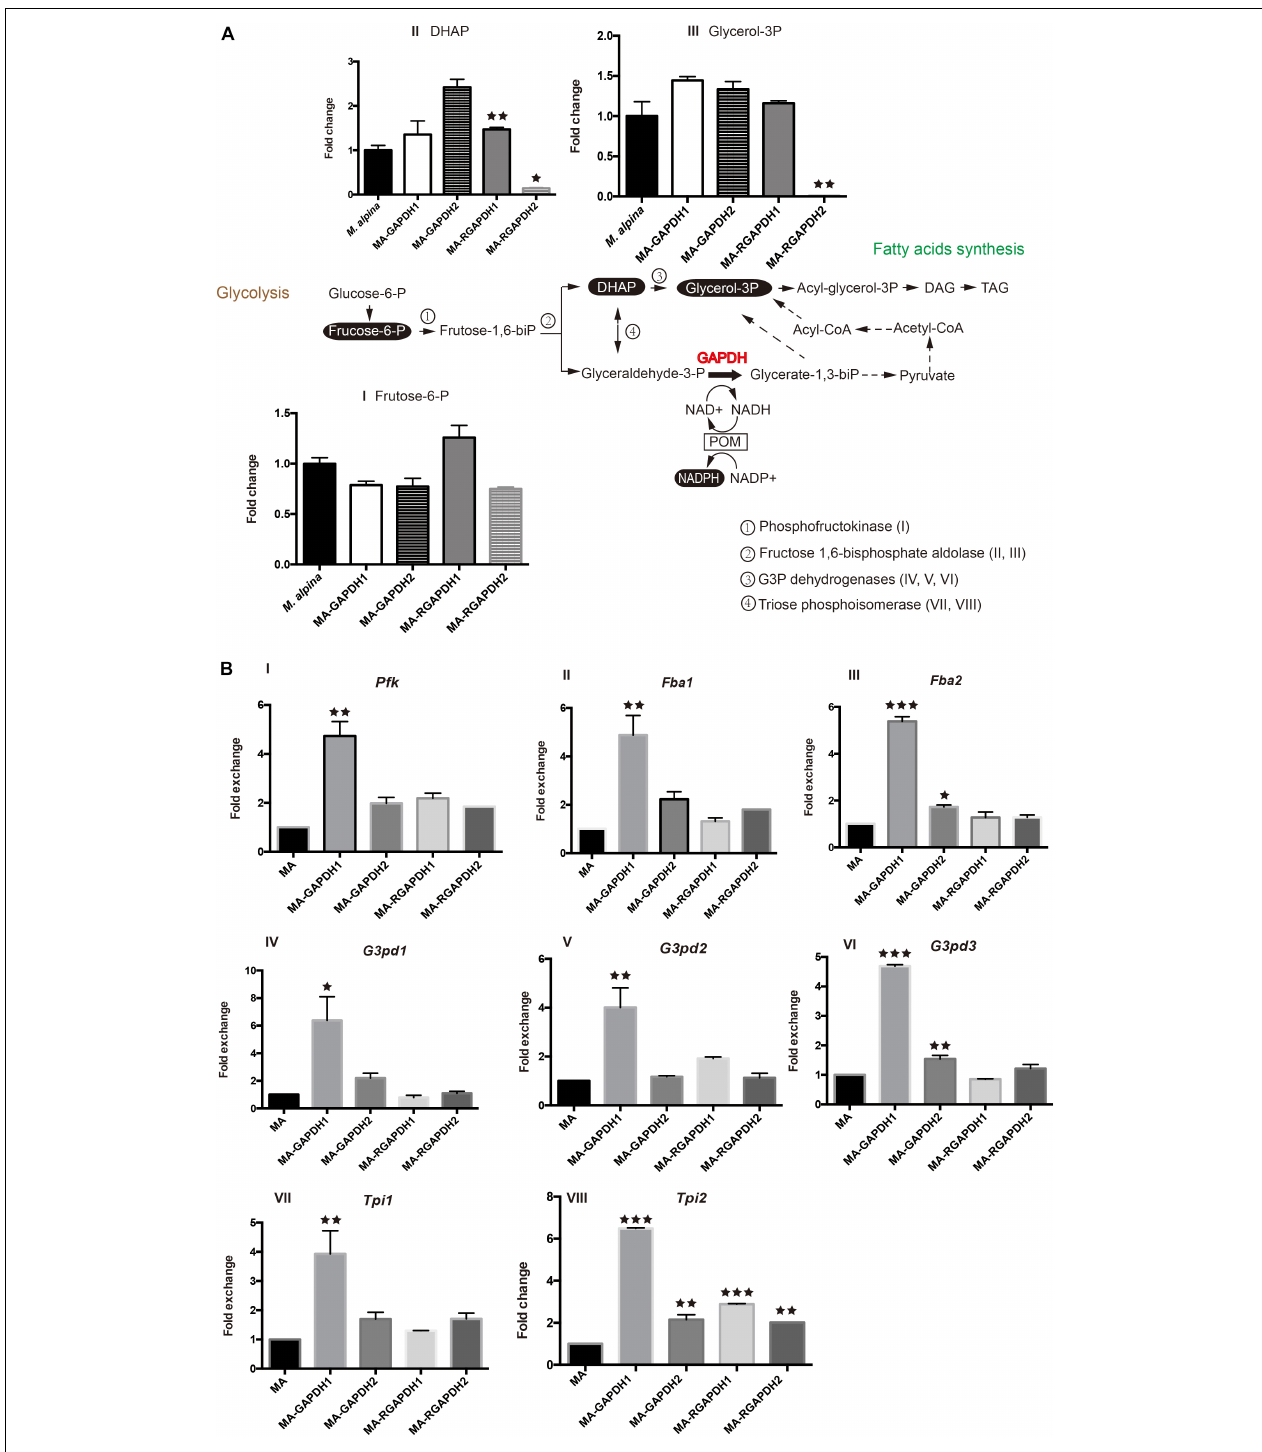
FIGURE 4 | Metabolic analysis of the pathways the overexpression transformants and RNA interference transformants (A) substrate and product analysis of the GAPDH pathway; (B) transcription level of the selected genes. P represents the abbreviation of phosphate, glucose-6-P-glucose-6-phosphate, frucose-6-P-frucose-6-phosphate, frucose-1,6-biP-frucose-6-biphosphate, DHAP-dihydroxyacetone phosphate, glycerol 3P-glycerol-3-phosphate, acyl-glycerol-3P- acyl-glycerol-3-phosphate, DAG-diacylglycerol, TAG-triacylglycerol, glyceraldehyde-3-P- glyceraldehyde-3-phosphate, glycerate-1,3-biP-glycerate-1,3-biphosphate, POM-pyruvate/oxaloacetate/malate enzyme cycle, Pfk -phosphofructokinase, Fba -fructose-1, 6-biphosphate aldolase, G3pd- Glycerol-3-phosphate dehydrogenases, Tpi -triose phosphoisomerase. * represents p < 0.05, ** represents p < 0.01, *** represents p < 0.001.